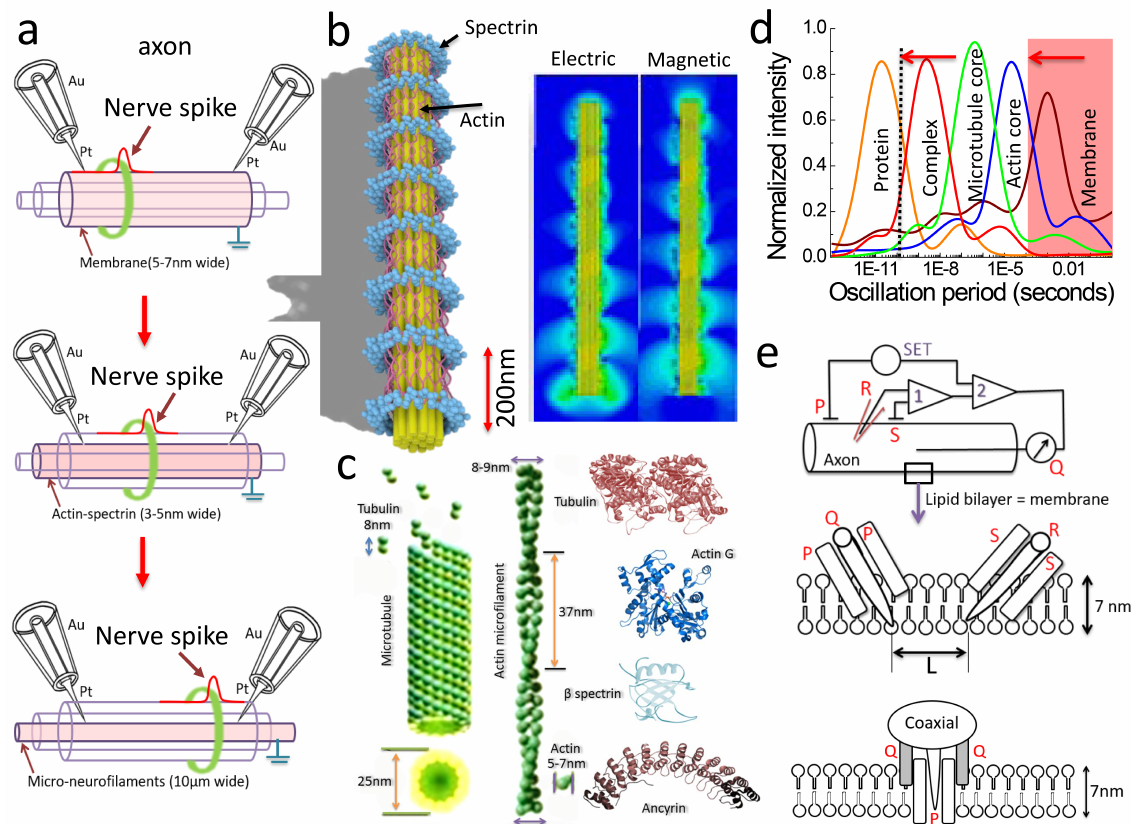
Fig. 2. Measuring natural oscillations deep inside a neuron during firing. (a) Schematic of a pair of coaxial probes entering synchronously first by making contact with the membrane (7 nm wide) (top panel). Then, the coaxial probes are inserted together using a piezo motor to contact the actin-beta- spectrin periodic lattice (middle panel). The bottom panel shows the microtubule-neurofilament core. A donut-shaped nerve spike (green) and a linear plot (red) flow left to right as one surfs towards the bottom panel. (b) A schematic of the simulated axon structure (8 rings, ~1.6 µ m) built using proteins (left) and its corresponding electric and magnetic field distribution at resonance at 5.5 THz. (c) The protein structures tubulin, actin (G), beta spectrin Ankyrin, microtubule, actin filament, tubulin are shown. (d) Coaxial probe measuring the natural oscillation of components, tubulin protein, microtubule = complex, microtubule core = assembly of microtubules & neurofilaments, actin core = actin-beta spectrin crystal; membrane lipid bilayer. We plot the periodicity of the natural oscillations, averaged over 20 neurons, 437 measurements, ~80 measurements per region. The shaded region limits a Patch-clamp technique to capture data, and the dotted line is where our probe is most sensitive. (e) The top panel shows old methods using a patch-clamp glass tube or nanotube. The central panel measures a lipid membrane. The bottom panel shows the measurement of a single ion channel. We insert probe directly Pt acquires data, Au holds ground potential